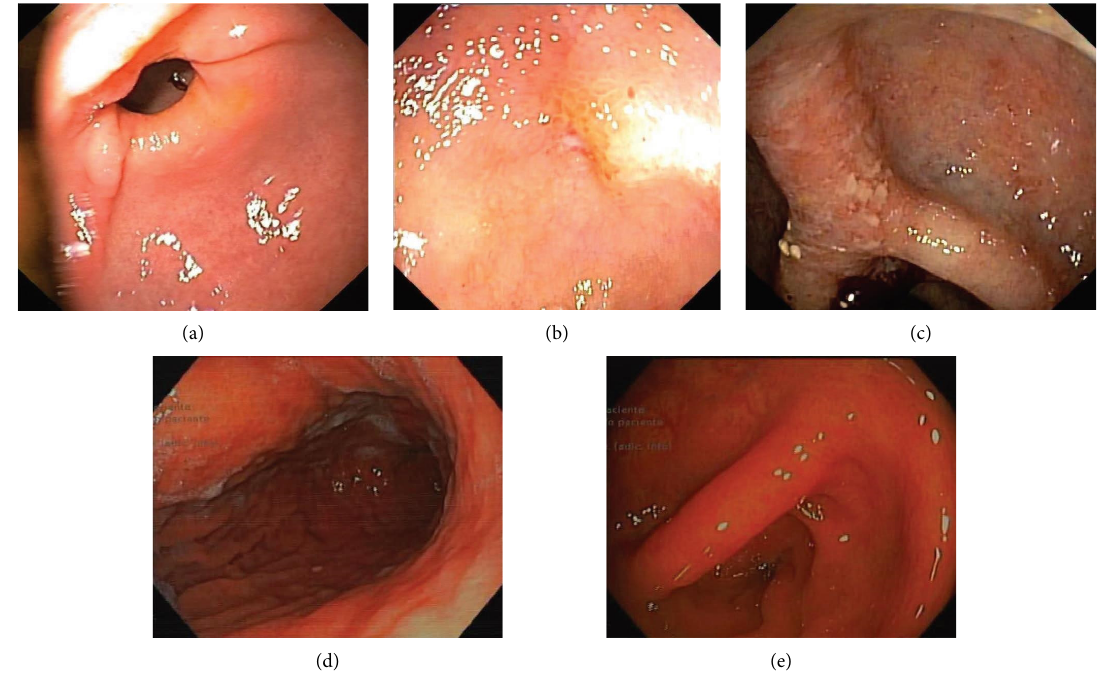
Figure 2: Comparison of endoscopic alterations in 2017 (a–c) and endoscopic healing in 2022 (d, e). (a) Hyperemia in the gastric antrum. (b) Erosion and edema in the terminal ileum. (c) Erosions, hyperemia, and edema in the transverse colon. (d) Normal gastric body. (e) Normal colonic mucosa in the transverse